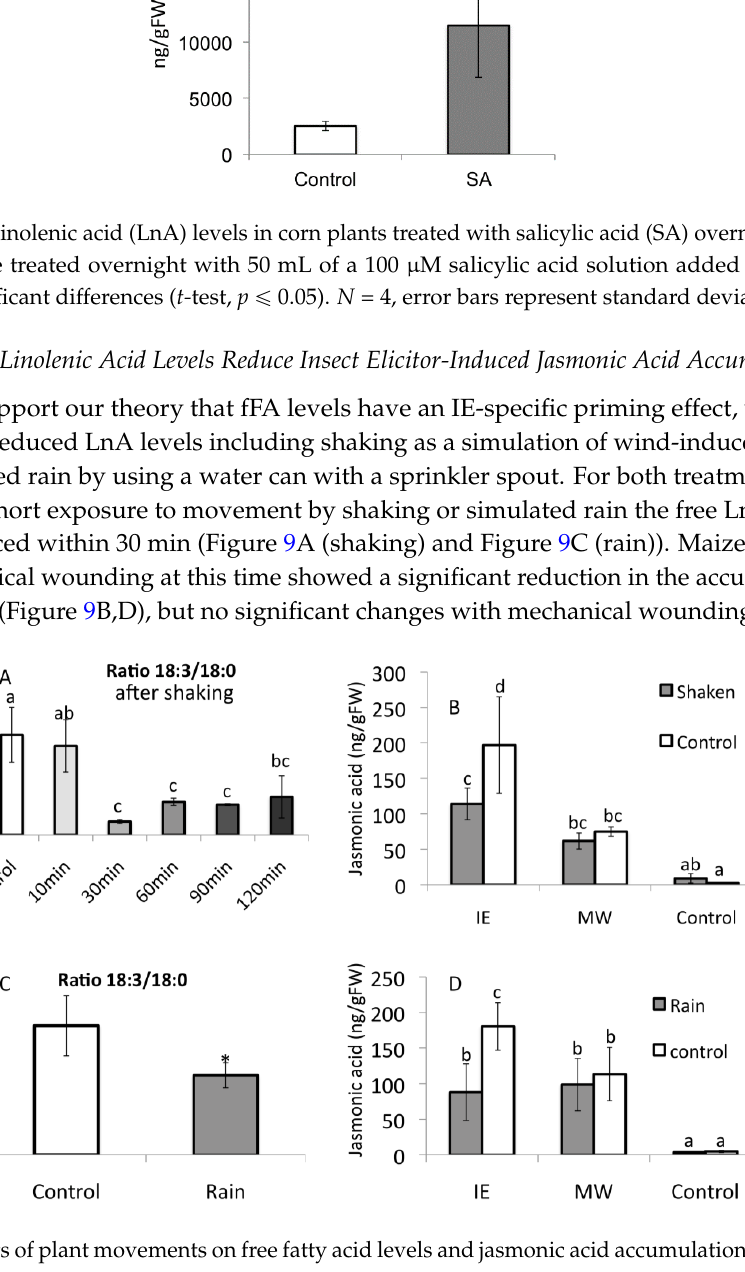
of shaking on free fatty acid levels in corn leaves. Plants were shaken for 15 s (upper panel); Free fatty